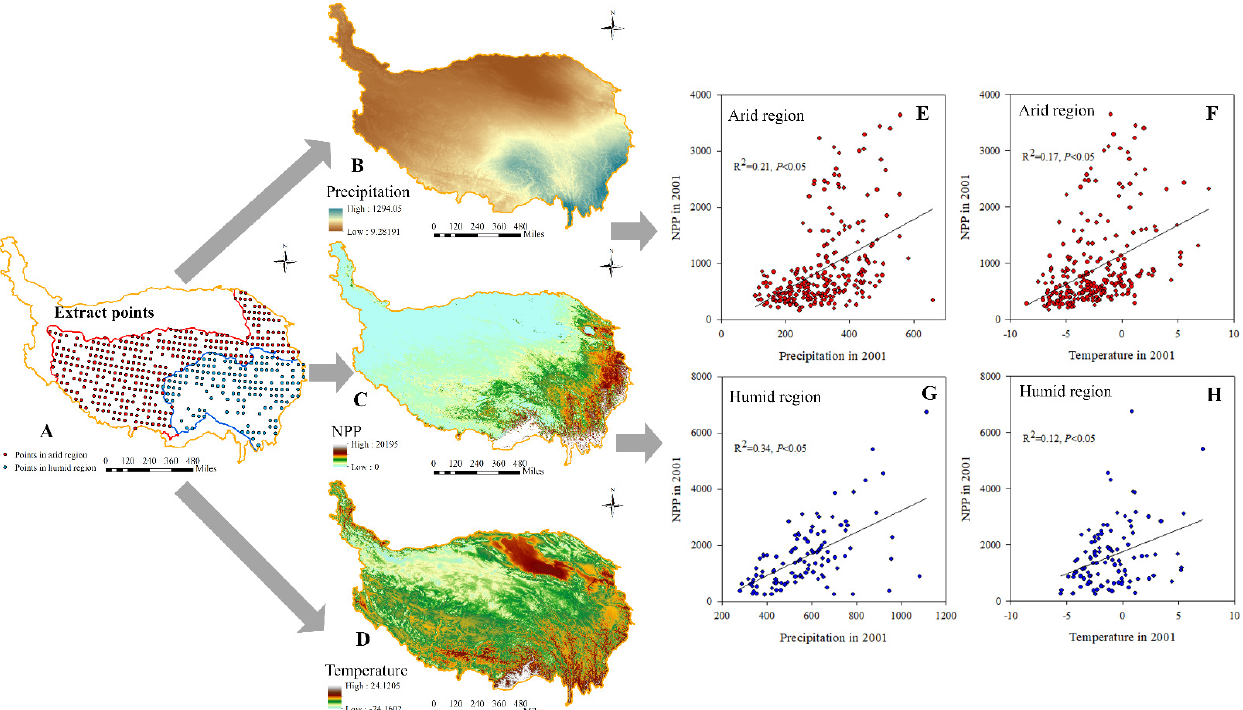
Figure A1. The values of NPP, temperature, and precipitation were extracted by fishnet from 2001 to 2019, then the relationships between climate and NPP were further analyzed by simple linear regression for every year. For example, in 2001, the extract points in arid and humid regions ( A ); and the spatial patterns of precipitation ( B ), NPP ( C ), and temperature ( D ); the relationships between precipitation and NPP, between temperature and NPP in the arid region ( E , F ) and in the humid region ( G , H ).